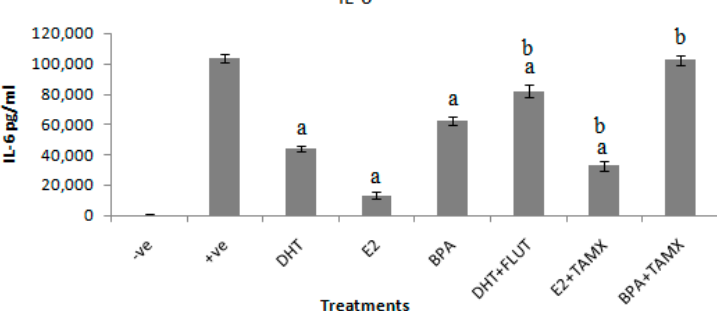
Figure 3. Effects of DHT, E2, and BPA alone and in combination with flutamide or tamoxifen on IL-6 secretion in RAW264.7 cells stimulated with 1 µ g / mL LPS. The stimulated cells were treated with 5 µ g / mL of DHT, E2, and BPA and 2 µ g / mL of flutamide (FLUT) or tamoxifen (TAMOX). Negative control was treated with normal medium and positive was control-treated with LPS (1 µ g / mL). The results are presented as mean ± SD; a -indicates that IL-6 level is significantly ( p < 0.001) lower than the positive control; b -indicates that IL-6 level is significantly ( p < 0.001) higher than levels of IL-6 secreted by cells treated with DHT, E2, and BPA alone.